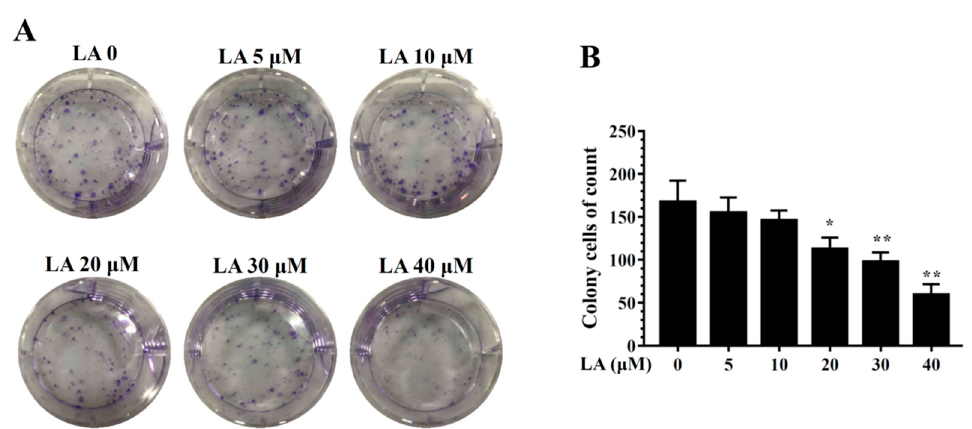
Figure 2. Effects of licochalcone A (LA) on clonogenic survival in MDA-MB-231 cells. ( A ) Cells were seeded on a culture plate and treated with LA for 24 h. Cells were fixed with 1% formalin-containing 1% crystal violet and colony formation inspected using an inverted microscope. ( B ) Colony cells were measured in culture plate. The data are presented as mean ± SD of three independent experiments (n = 6). * p < 0.05, ** p < 0.01 compared to untreated cells (0 μ M LA).